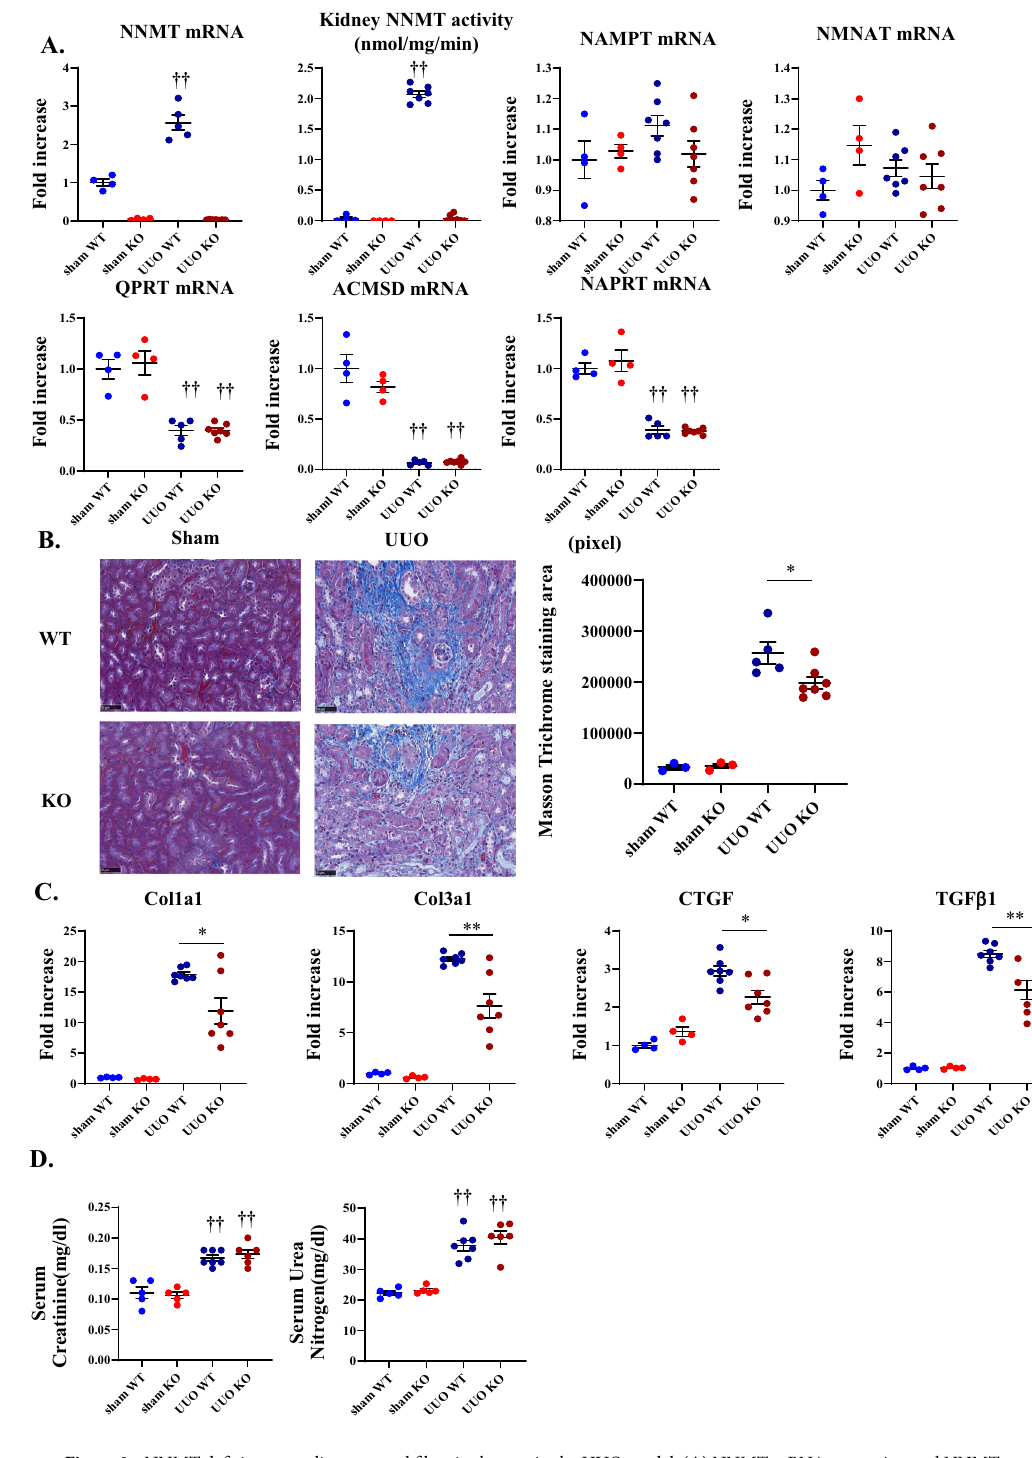
Figure 3. NNMT deficiency ameliorates renal fibrotic changes in the UUO model. ( A ) NNMT mRNA expression and NNMT activity, NAMPT, NMNAT, QPRT, ACMSD, and NAPRT mRNA expression were measured in NNMT-KO mice and WT littermates after UUO induction. The values shown are means ± SEM ( n = 4–7 per group). ( B ) Renal fibrosis was assessed by Masson-trichrome staining in the kidneys of NNMT-KO mice and WT littermates after UUO induction. The values shown are means ± SEM ( n = 3–7 per group). ( C ) Fibrosis-related genes were measured in the kidneys of NNMT-KO mice and WT littermates after UUO induction. The data represent means ± SEM ( n = 4–7 per group). ( D ) Renal function (serum creatinine and urea nitrogen) was measured in NNMT-KO mice and WT littermates after UUO induction. The values shown are means ± SEM ( n = 4–7 per group). UUO, unilateral ureter obstruction; NNMT, nicotinamide N-methyltransferase; NMNAT, nicotinamide mononucleotide adenyltransferase; NAMPT, nicotinamide phosphoribosyltransferase; QPRT, quinolinate phosphoribosyltransferase; ACMSD, alpha-amino-beta-carboxy- muconate-semialdehyde decarboxylase; NAPRT, nicotinate phosphoribosyltransferase; Col, collagen; CTGF , connective tissue growth factor; TGF, transforming growth factor. * P < 0.05, ** P < 0.01 versus WT mice. † P < 0.05, †† P < 0.01 versus the same genotype control mice (sham-operated